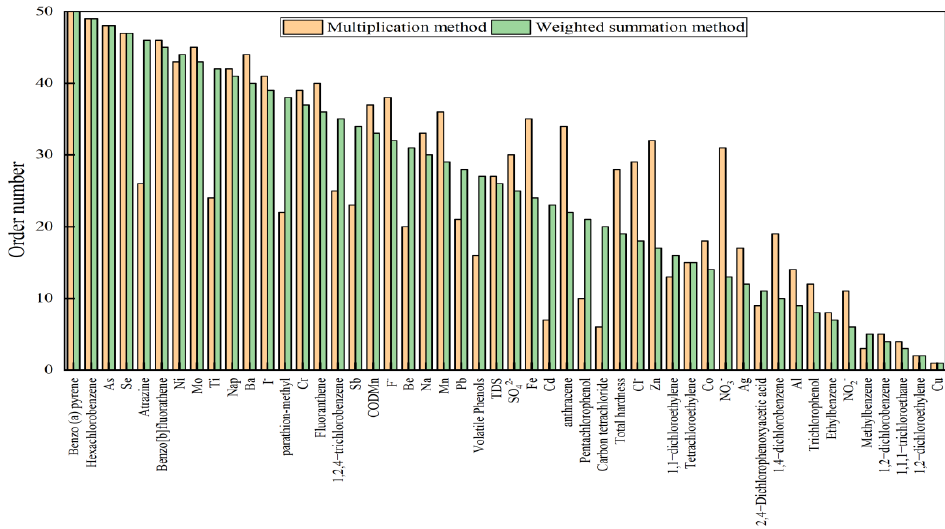
Figure 10. Comparison of screening results between the two methods.